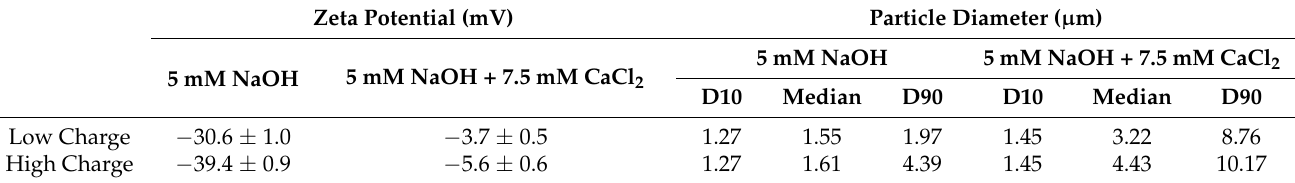
Table 1. Zeta potential and diameters (D10, median and D90 values) of particles in suspensions after filtration. The suspensions were formed by suspending higher and lower charged PS–PAA microparticles in DI water together with NaOH (w/o Ca) or NaOH as well as CaCl 2 (w/ Ca), respectively.